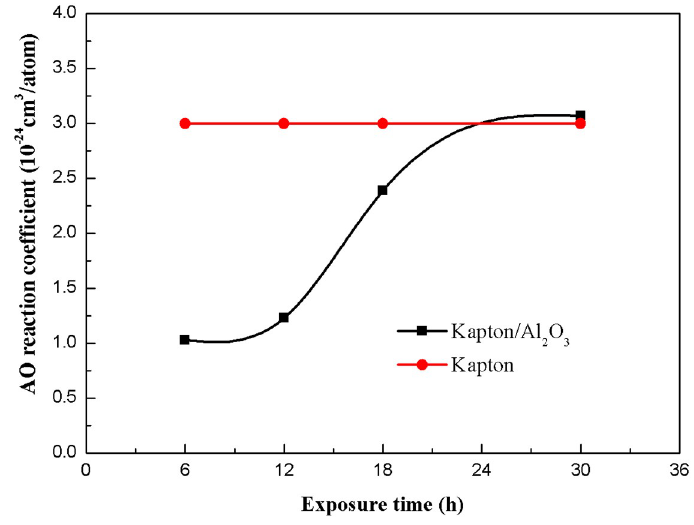
Figure 11. Atomic oxygen reaction coefficient of the Kapton/Al 2 O 3 surface nanocomposite film.